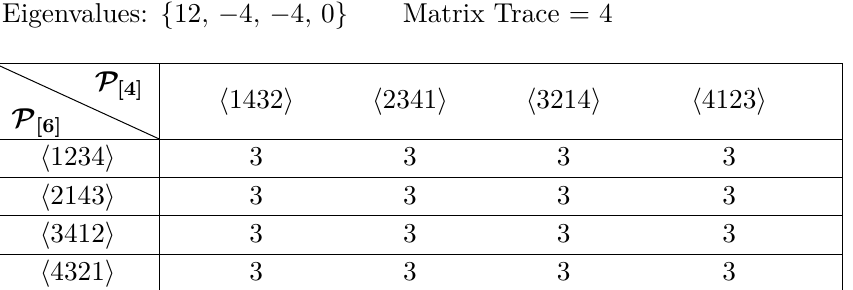
Table 9. {P} 6 − {P} 3 two-point correlator values.